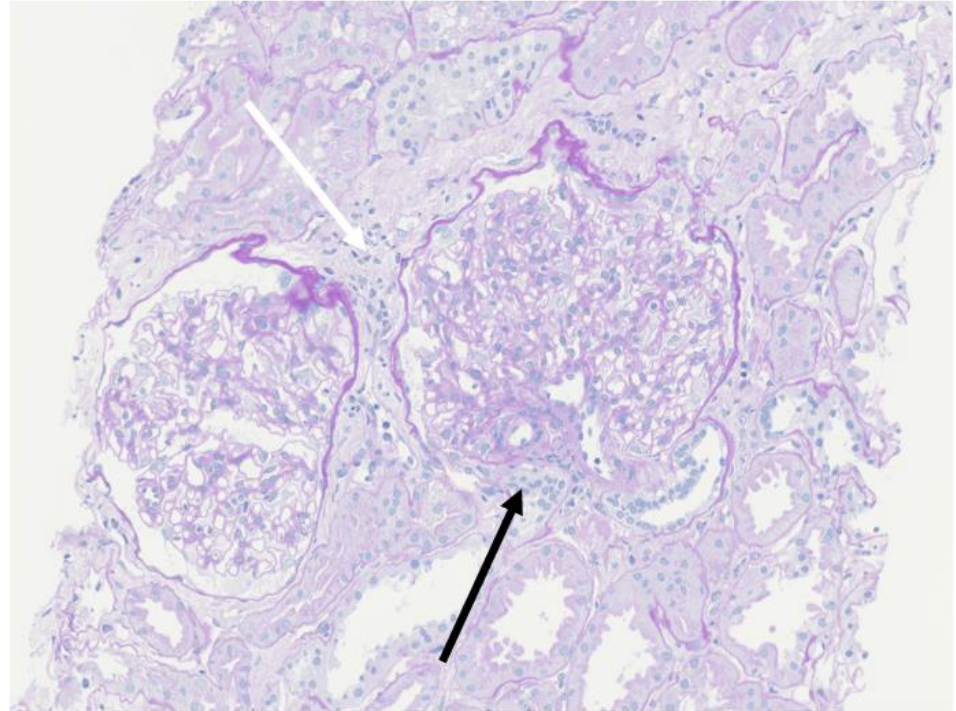
Figure 1. The mean diameter of the glomeruli of this patient (348.23 μm) was much larger than that of normal glomeruli (168 ± 12 μm). Periodic Acid Schiff staining (magnification: 200×). White arrow: partial focal interstitial fibrosis. Black arrow: segmental sclerosis with adhesion to the Bowman’s capsule.